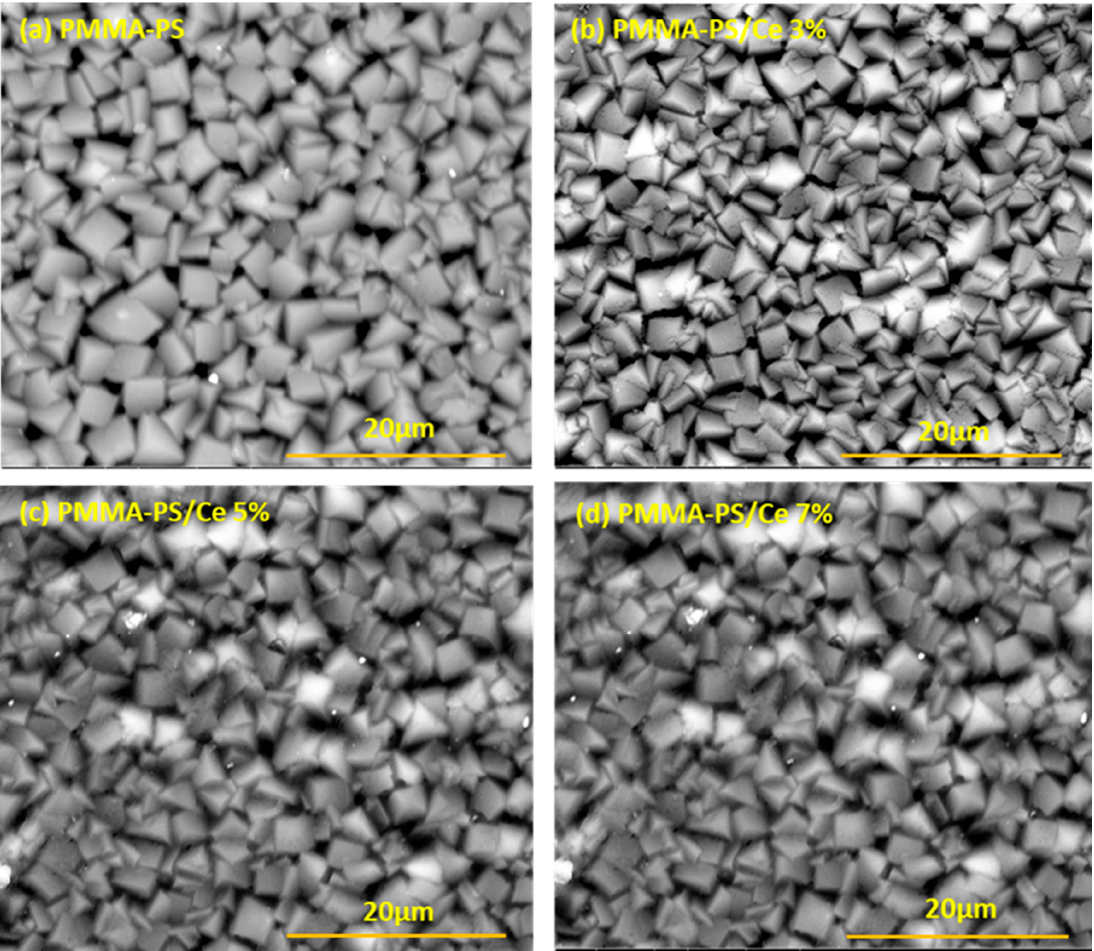
Figure 12. SEM (scanning electron microscope) cross sections of chemically developed images of thin-films of ( a ) PMMA- PS (polymethyl methacrylate-polystyrene) block copolymers, ( b ) PMMA-PS/CeO 2 3%, ( c ) PMMA-PS/CeO 2 5%, and ( d ) PMMA-PS/CeO 2 7%.